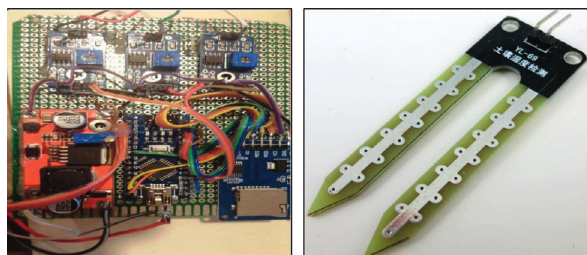
Figure 9: Moisture sensors and data logger for gravimetric moisture content